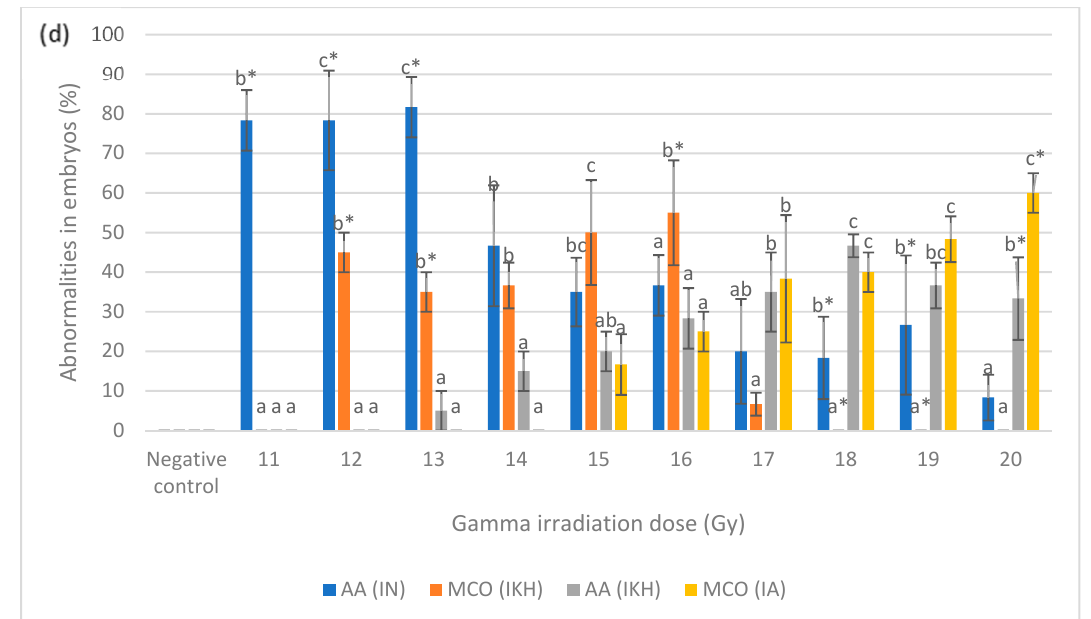
Figure 5. ( a ) Abnormalities produced for each dose in the irradiated zebrafish embryos at 24 h post ‐ irradiation; ( b ) abnormalities produced for each dose in the irradiated zebrafish embryos at 48 h post ‐ irradiation; ( c ) abnormalities produced for each dose in the irradiated zebrafish embryos at 72 h post ‐ irradiation; ( d ) abnormalities produced for each dose in the irradiated zebrafish embryos at 96 h post ‐ irradiation. a*, b*, c* and d* indicate significant difference ( p < 0.05) compared to other abnormalities. a, b, c, ab and bc indicate no significant difference ( p > 0.05) compared to other abnormalities.